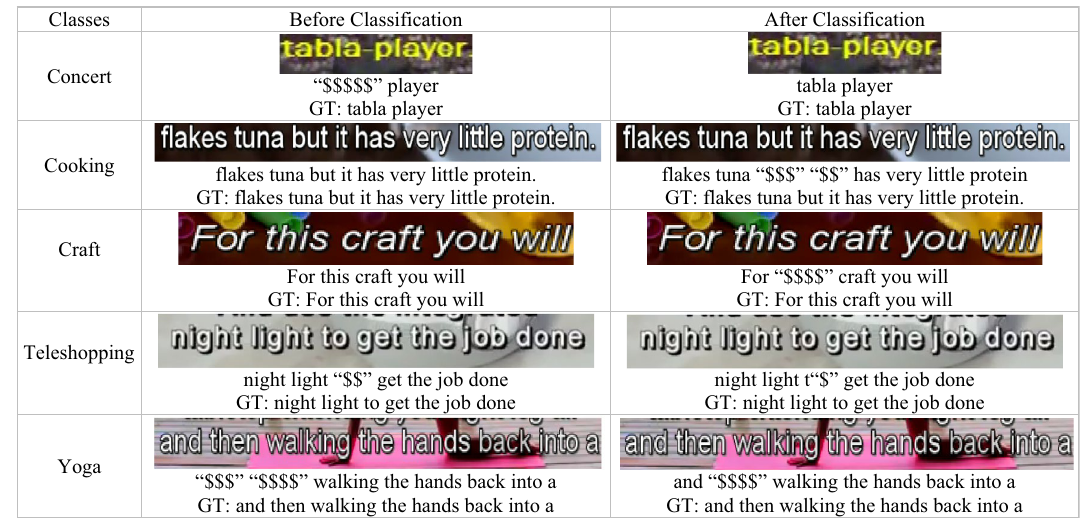
Fig. 11 Qualitative results of the recognition method on our dataset before and after classification. GT denotes ground truth, “$” denotes recognition method gives